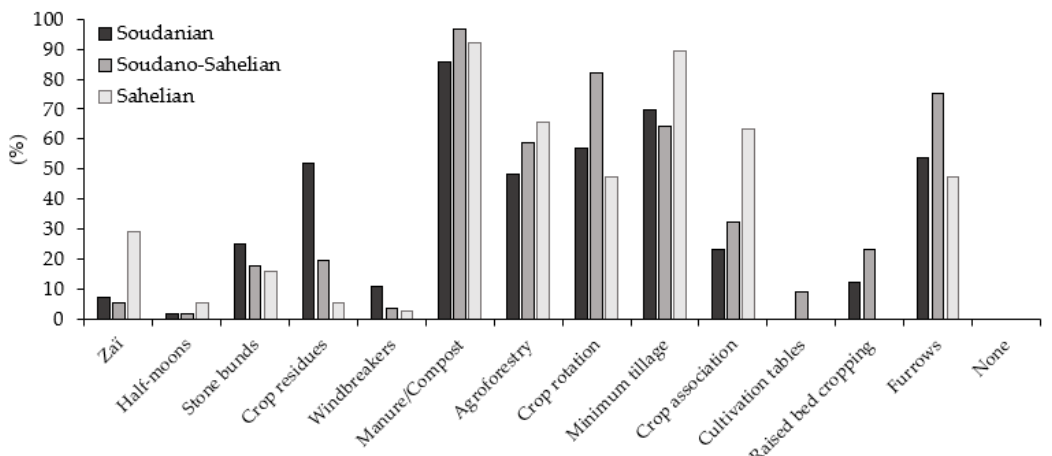
Figure 5. Soil and land management strategies in the different agroclimatic zones (Soudanian, Soudano-Sahelian, Sahelian).